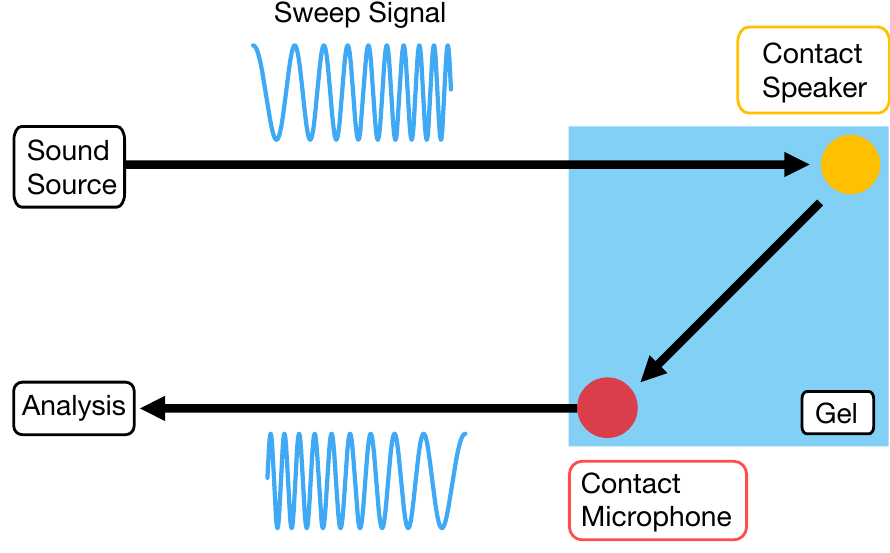
Figure 1. System